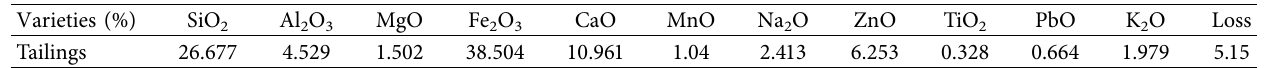
Figure 1: Fundamental characteristics of the studied tailings: (a) particle size distribution curve; (b) X-ray diffraction curve. Table 1: Chemical composition of the tailings used.